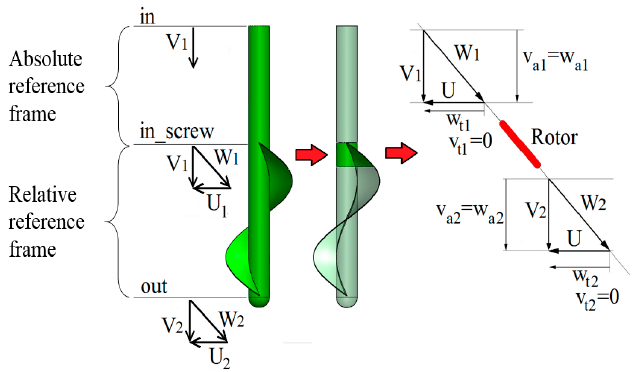
Figure 7. Velocity triangle at the in and out sections.